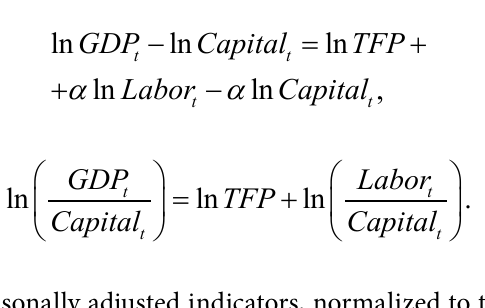
-5%-4%-3%-2%-1%0% 2000 2001 2002 2003 2004 2005 2006 2007 2008 2009 2010 2011 2012 2013 Figure 1. Decomposition of potential GDP growth in capital, labor, aggregate factor productivity